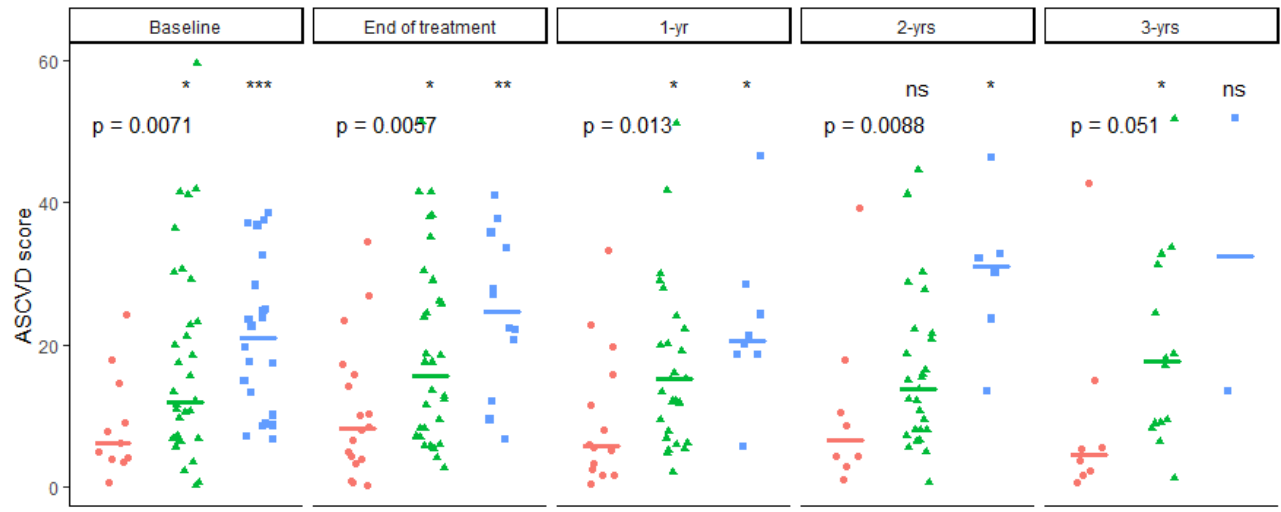
Figure 2. Dynamics of ASCVD and FIB-4 scores with time at baseline and follow-up (mean) ASCVD, Atherosclerotic Cardiovascular Disease 2013; FIB-4, fibrosis-4 index.